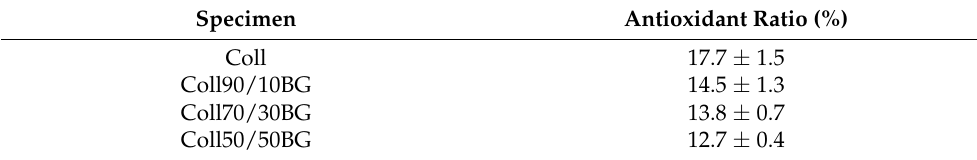
Table 4. Antioxidant ratio of collagen material modified with β